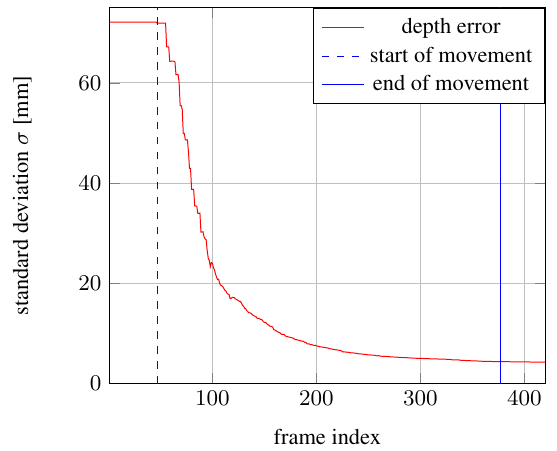
Figure 7. Standard deviation of the measured depth for a chess- board target in 3 . 183 m distance to the camera. From the first to the last frame the camera was translated by 20 cm in vertical direction.